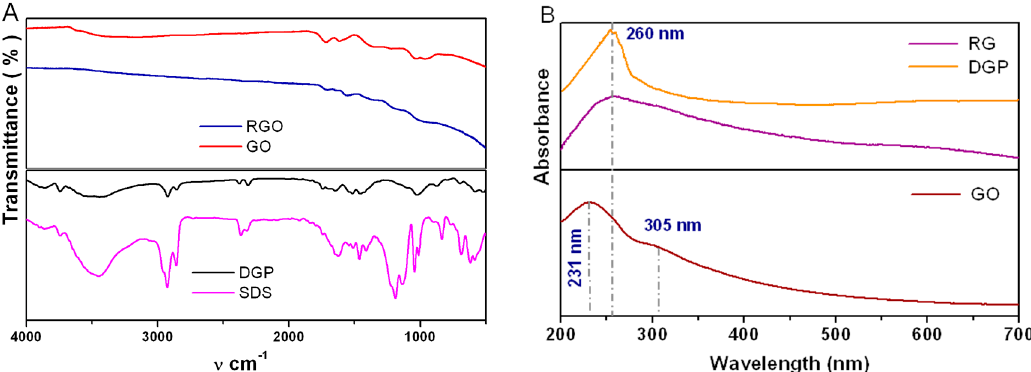
Figure 2. ( A ) FTIR spectra of sodium dodecylbenzenesulfonate (SDS), dispersed graphene nanoplatelets (DGP), reduced graphene oxide (RGO) and graphene oxide (GO); and ( B ) UV spectra of DGP, RG and GO.